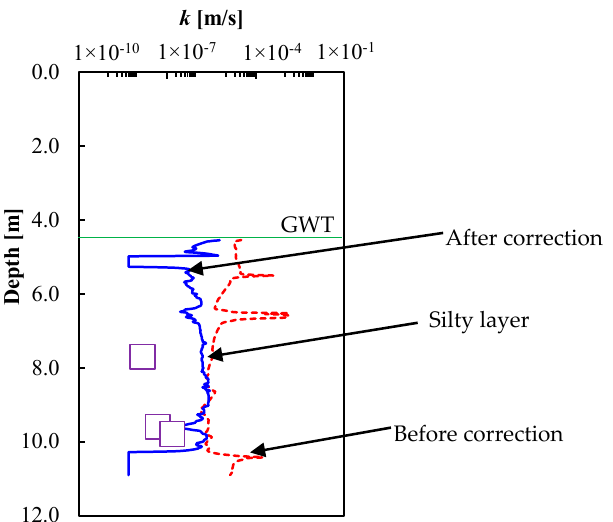
Figure 10. Measured and estimated hydraulic conductivity profile for SR18, Indiana, USA site.